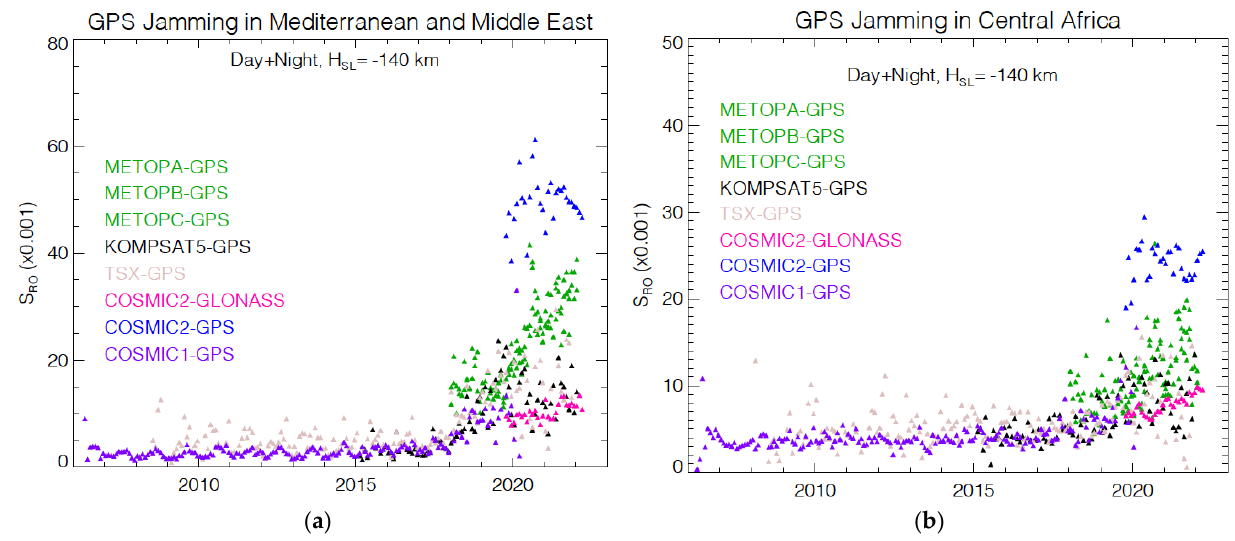
Figure A12. Time series of the monthly averaged GNSS jamming ( a , b ) amplitude as observed in the S RO at H SL = −140 km. The noisier data from TSX and KOMPAST5 than others are mostly due to a fewer number of RO measurements from these satellites. The earlier period of MetOp-A/B S RO data are excluded in the plot because of their testing periods for the open-loop operation.